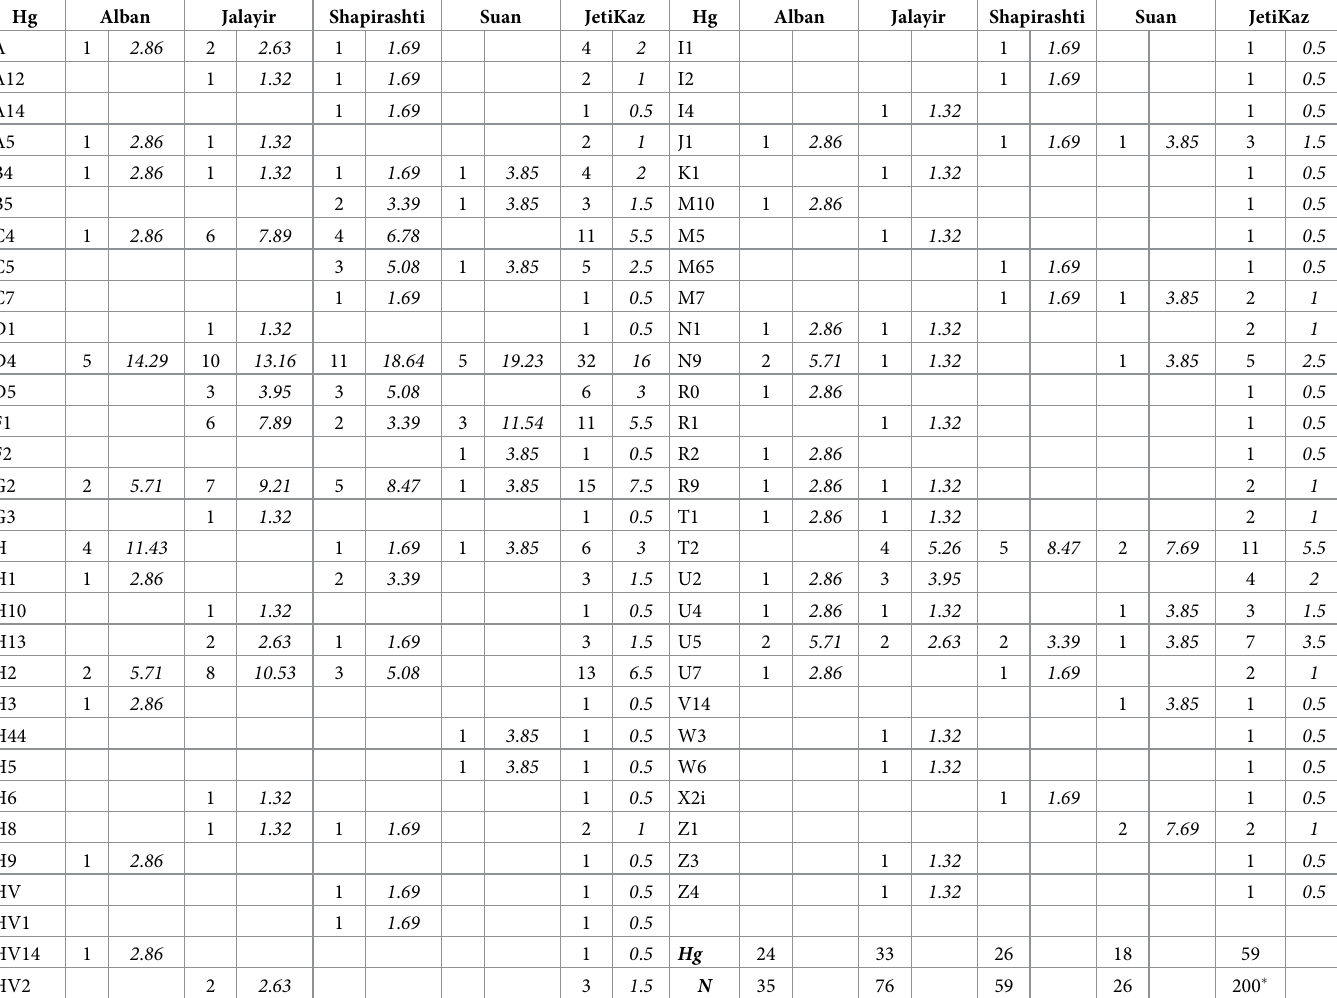
Table 1. Mitochondrial DNA haplogroup frequencies in Kazak populations from Jetisuu,